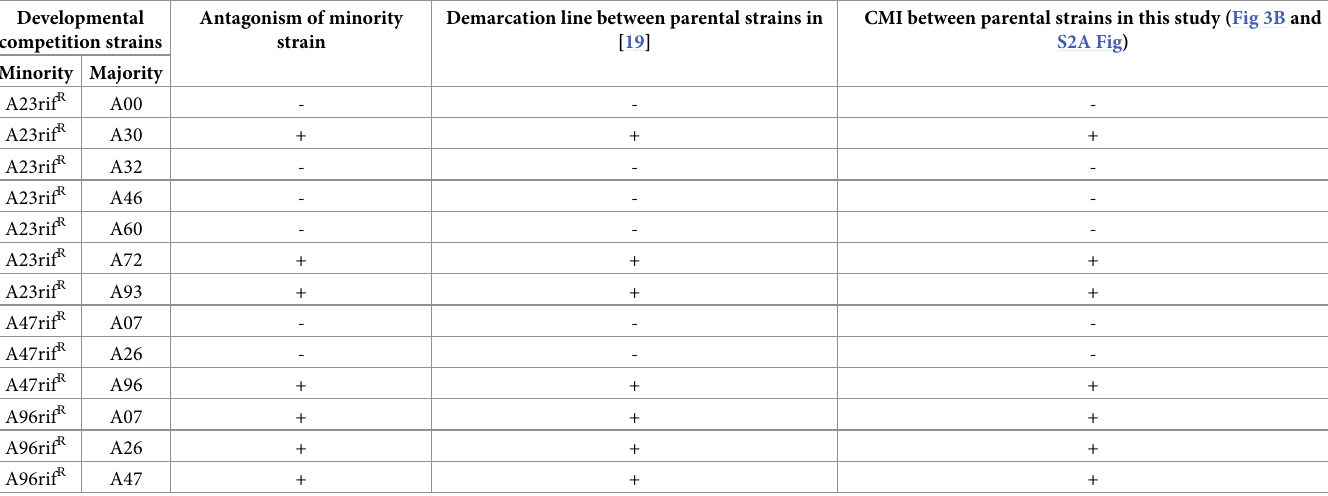
Table 3. Patterns of developmental antagonism and colony